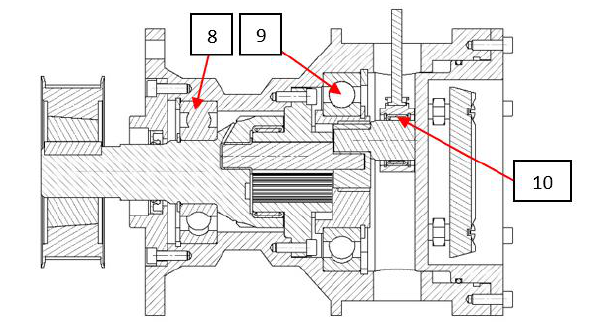
Fig. 4. Hypocycloidal drive pump – cross section with marked bearings